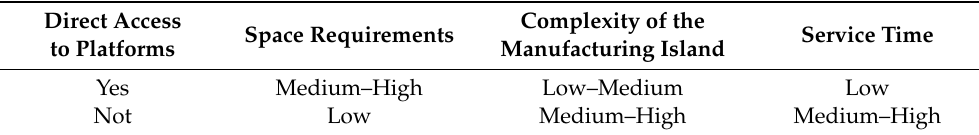
Table 4. The impact of the distribution of the manufacturing island.